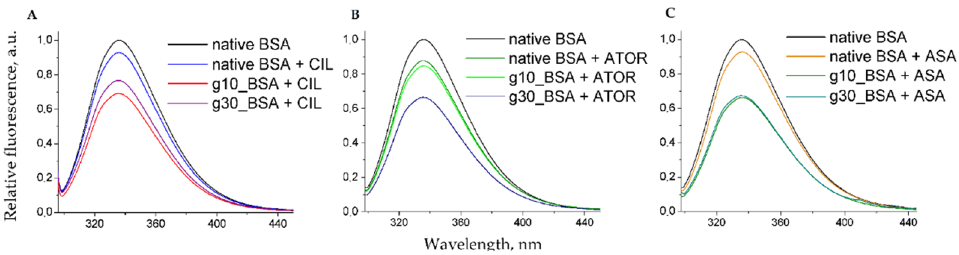
Figure 3. Fluorescence emission spectra of native BSA, g10_BSA and g30_BSA in the presence of cilazapril ( A ), atorvastatin ( B ) and acetylsalicylic acid ( C ) recorded at λ ex 295 nm.